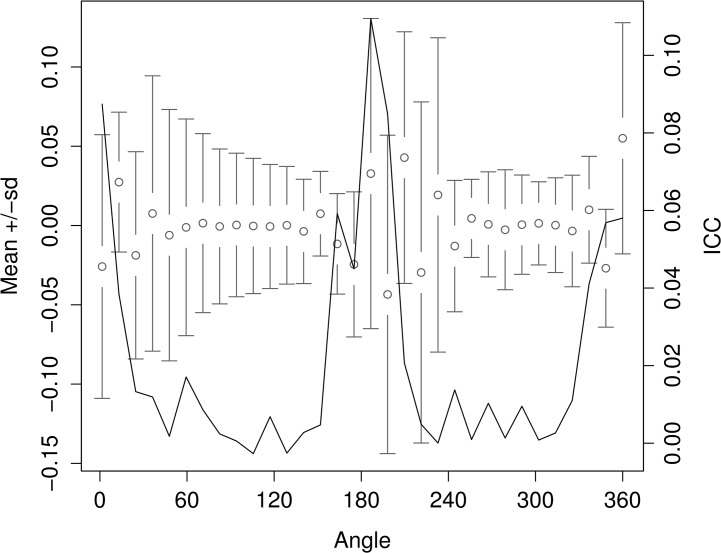
Mean and standard deviation (sd) of the Wavelet coefficients (grey) representing shape for all combined otoliths and the proportion of variance among herring populations or the intraclass correlation (ICC, black solid line).The horizontal axis shows angle in degrees (°) based on polar coordinates where the centroid of the otolith is the center point of the polar coordinates.